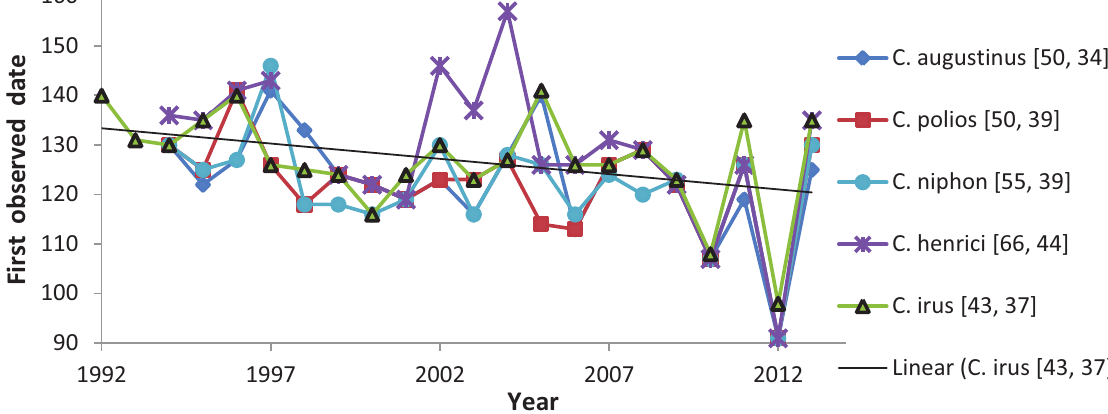
Figure 2. First observed date for each elfin species in central Wisconsin or in 12 instances from farther north if found there earlier than in central Wisconsin. Numbers in parentheses: difference in days between earliest and latest first observed date; difference in days in largest change in first observed date between consecutive years. Y axis: 90 = 31 Mar, 160 = 9 June.